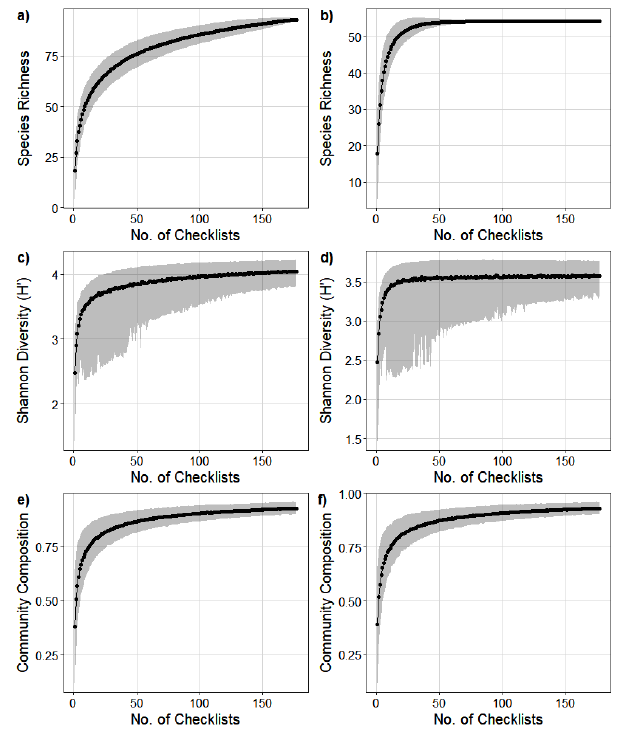
Fig. 4 . Accumulation curves for (a) species richness with all data, (b) species richness with infrequently recorded species excluded, (c) species diversity with all data, (d) species diversity with infrequently recorded species excluded, (e) community composition with all data, and (f) community composition with infrequently species excluded, for our example greenspace, Buena Vista Park, San Francisco, California. Results are shown for both analyses, all the data, and for those species recorded on > 5% of all checklists at the site. See Appendix 5 for directions and coding to calculate the accumulation